Question: Briefly state, in one sentence, what is plotted here.
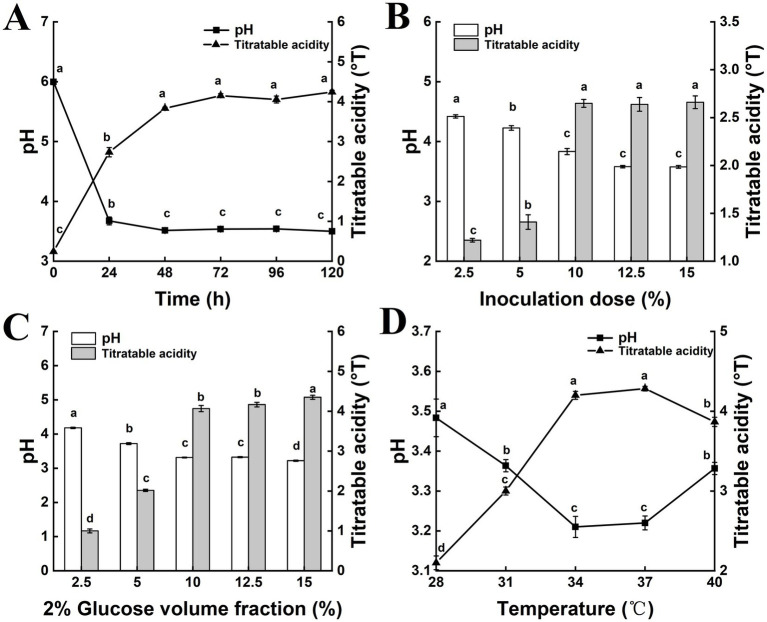
Answer: Optimization of fermentation parameters for sour porridge inoculated with strain GXUN74722. (A) Fermentation time; (B) Inoculation dose; (C) 2% glucose volume fraction; (D) Fermentation temperature (all on pH and titratable acidity).